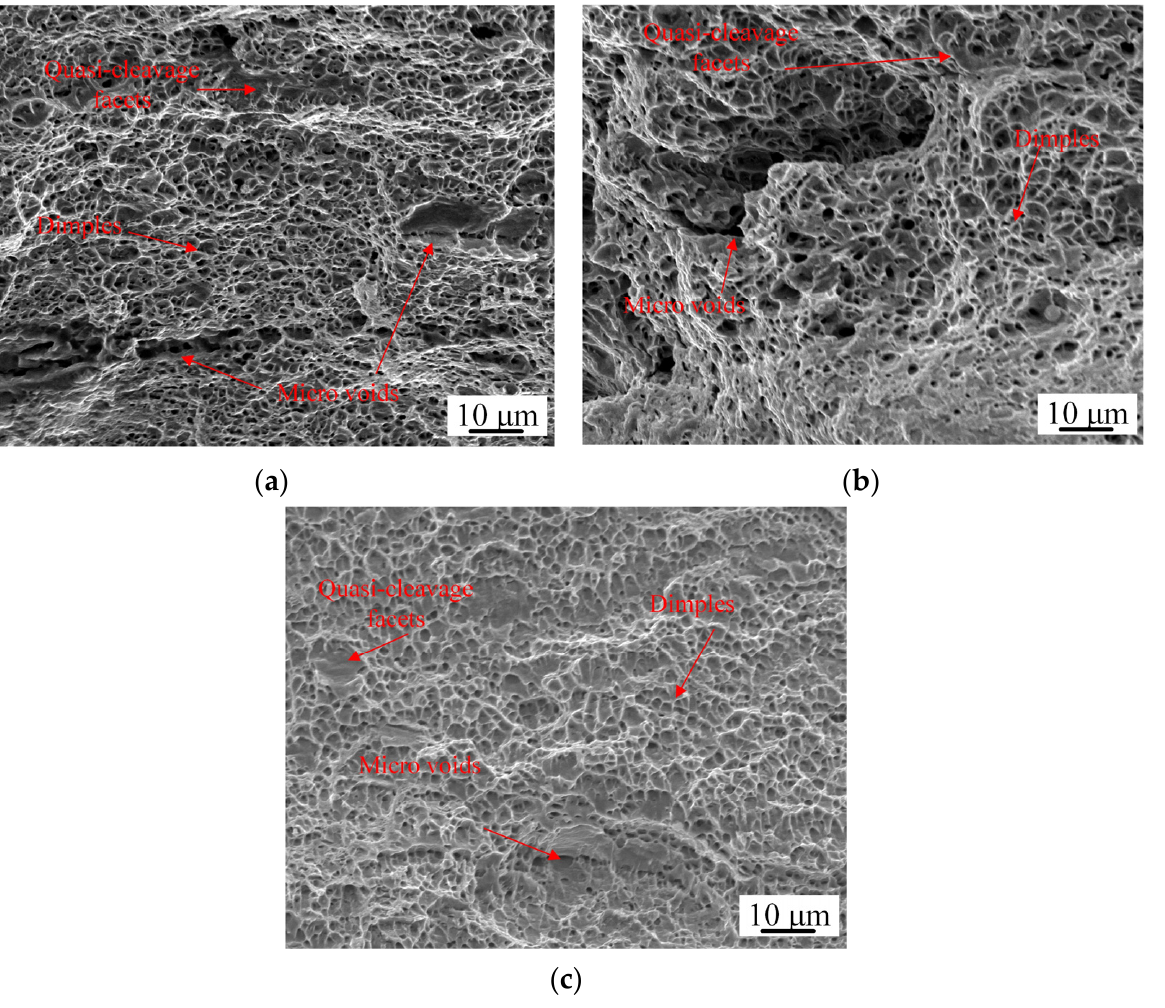
Figure 8. Fracture surfaces of different thicknesses in the WM: ( a ) Y = 4.3 mm; ( b ) Y = 2.5 mm; ( c ) Y = 0.7 mm.